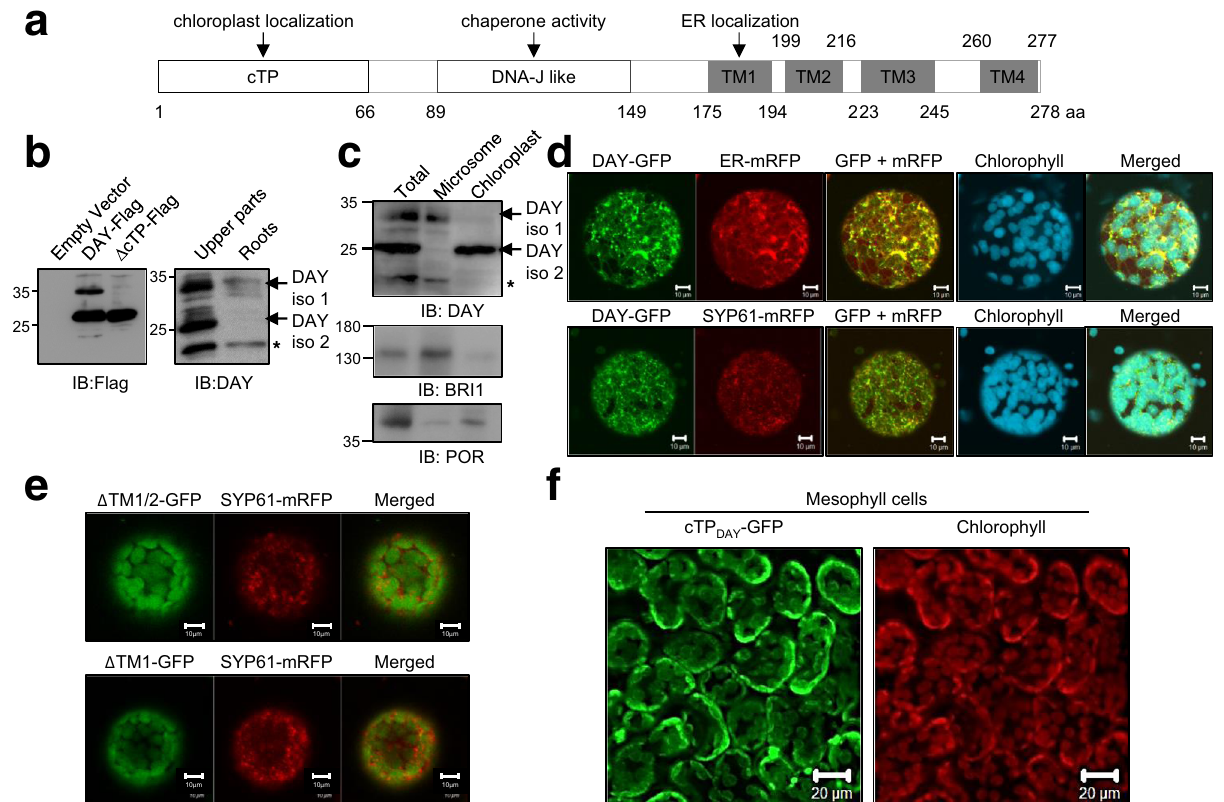
Fig. 2 Localization of DAY in chloroplasts and the endomembrane system depends on the cTP and TM1, respectively. a Schematic representation of DAY with its chloroplast transit peptide (cTP), DnaJ-like domain (JL) and four transmembrane domains (TM1 – 4). The amino acid (aa) positions that de fi ne the domains are indicated at the bottom. b DAY exists in two major isoforms in vivo. N. benthamiana leaves expressing either full-length FLAG-tagged DAY (DAY-Flag) or a variant lacking the chloroplast transit peptide ( Δ cTP-Flag) were subjected to immunoblotting (IB) analysis using anti-Flag antibodies (left panel). Immunoblot analysis of aerial and root tissues from wildtype Arabidopsis seedlings using anti-DAY antibodies (right panel). DAY iso 1 and DAY iso 2 refer to major isoforms of DAY. The asterisk indicates a minor isoform of DAY that is consistently detected. c Subcellular fractionation. WT seedling extracts were fractionated and subjected to immunoblotting with an anti-DAY antibody. BRI1 and POR were detected as the markers for microsomal fractions and chloroplasts, respectively. d DAY localizes to chloroplasts, ER, and TGN/EE. Co-localization of DAY with ER-mRFP (upper panel), SYP61- mRFP (lower panel), and chlorophyll support is shown. mRFP and DAY-GFP fusion proteins were transiently co-expressed in N. benthamiana leaves by agroin fi ltration, and protoplasts isolated from in fi ltrated leaves were imaged using confocal laser scanning microscopy (CLSM). SYP61 (SYNTAXIN OF PLANTS 61) was used as a TGN/EE marker. Scale bar, 10 µ m. e TM1 is responsible for ER and TGN/EE localization of DAY. GFP fusions to a DAY deletion series were co-expressed with SYP61-mRFP in N. benthamiana leaves via agroin fi ltration and protoplasts were observed by CLSM. Scale bar, 10 µ m. f The DAY cTP is suf fi cient for chloroplast targeting. cTP DAY -GFP fusion proteins were expressed in N. benthamiana leaves via agroin fi ltration and mesophyll cells were imaged using CLSM. Scale bar, 20 µ